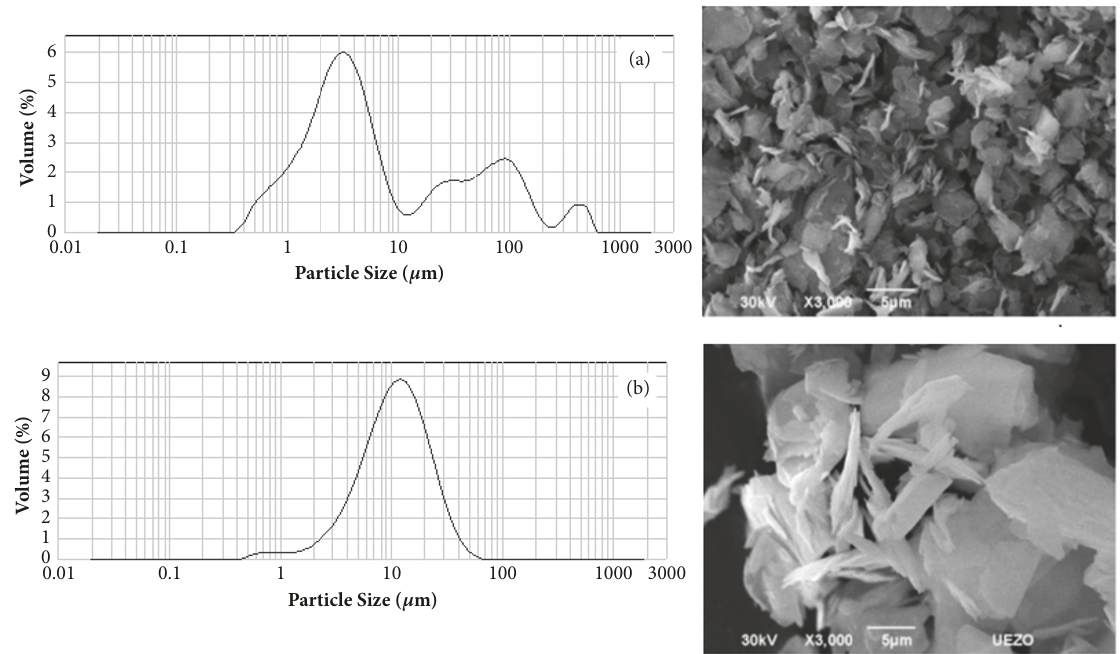
Figure 1: Particle size distribution and SEM micrographs of (a) Talc A and (b) Talc